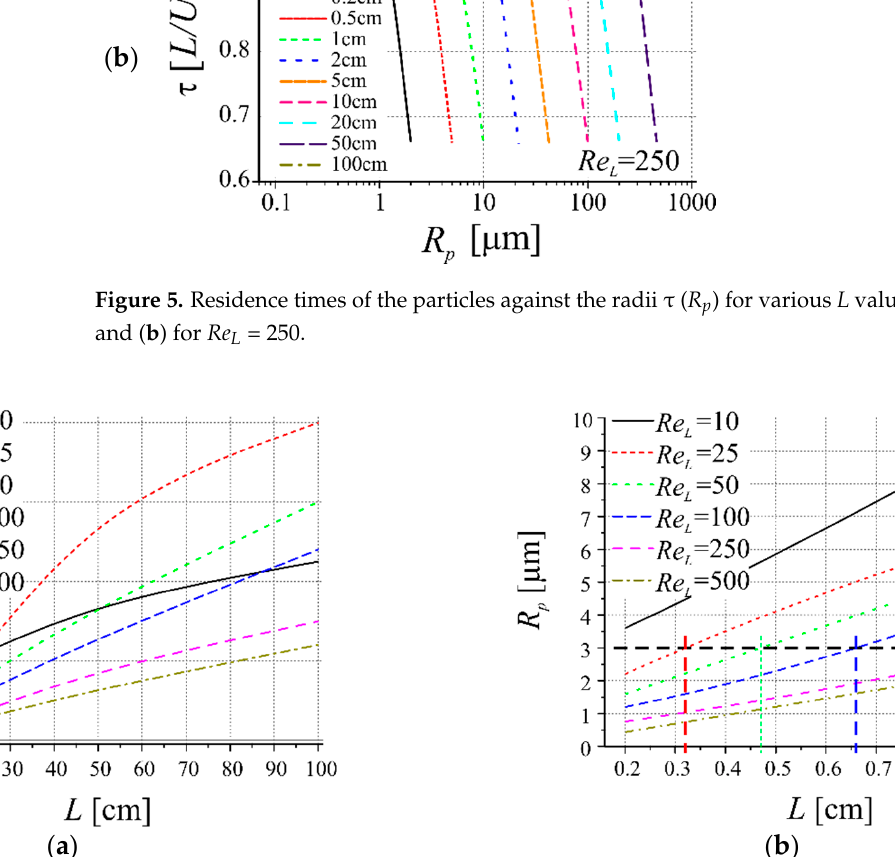
Figure 5. Residence times of the particles against the radii τ ( R p ) for various L values: ( a ) for Re L = 25 and ( b ) for Re L = 250.